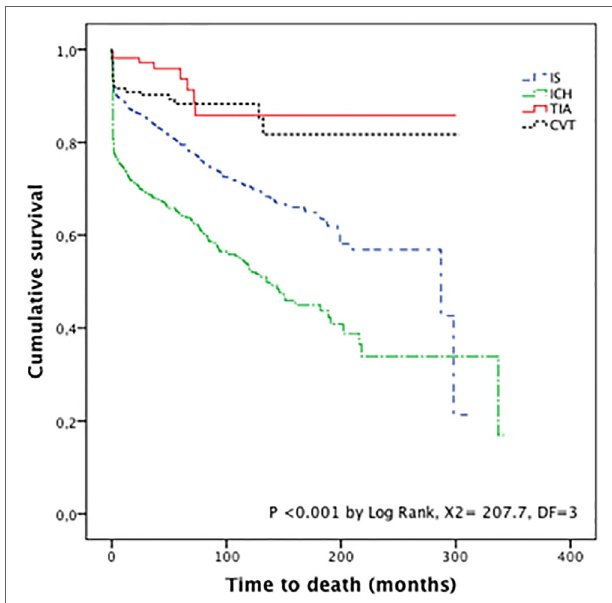
FigUre 2 | Kaplan–Meier survival curves by stroke subtype. Abbreviations: IS, ischemic stroke; ICH, intracranial hemorrhage; TIA, transient ischemic attack; CVT, cerebral venous thrombosis.